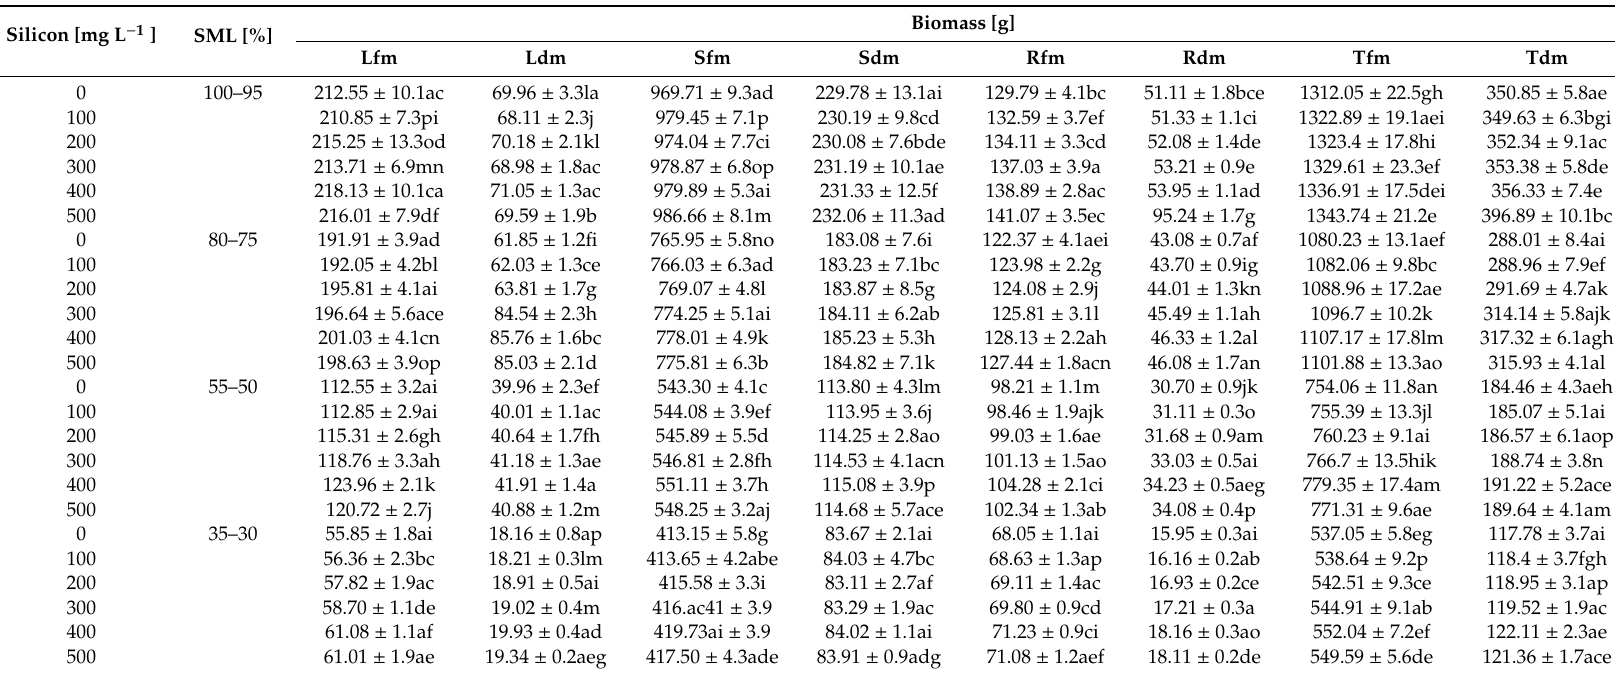
Di ff erent letters represent statistically significant di ff erences ( p <